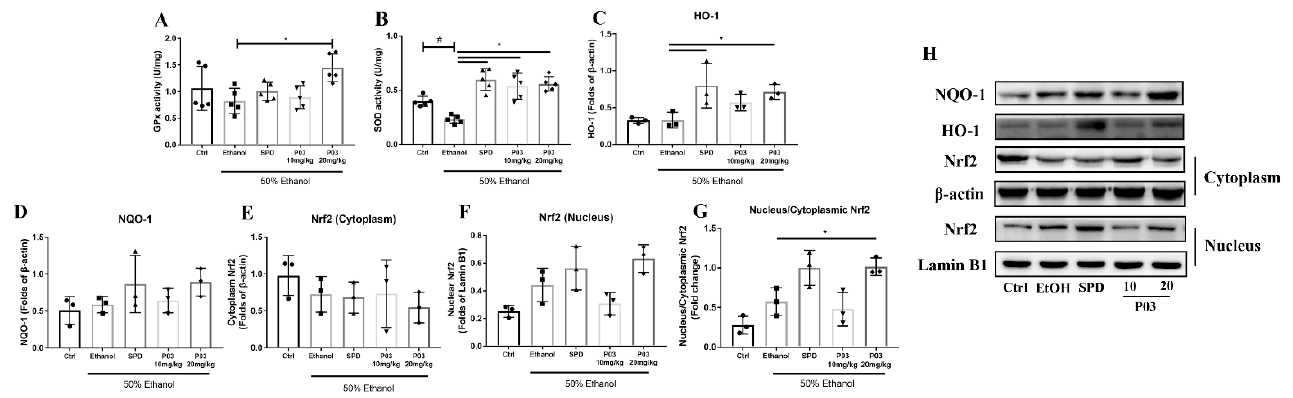
Figure 4. Alterations in antioxidant enzymes in rodent livers and immunoblots of HO-1, NQO-1